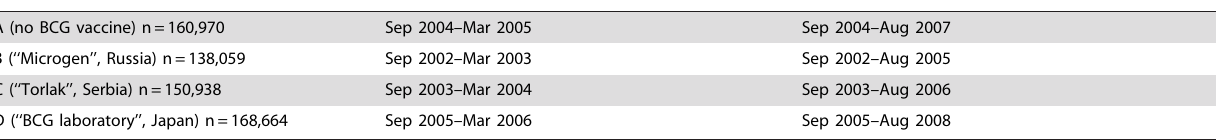
Cohort (vaccine used) and number of newborns in cohort